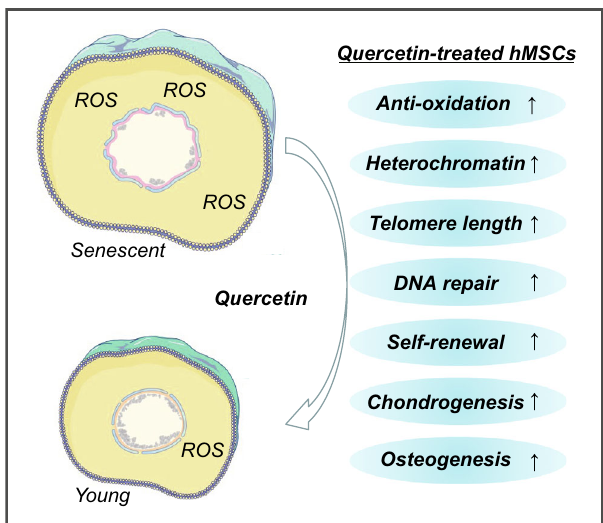
Figure 11. A proposed model illustrating the geroprotective effects of Que in